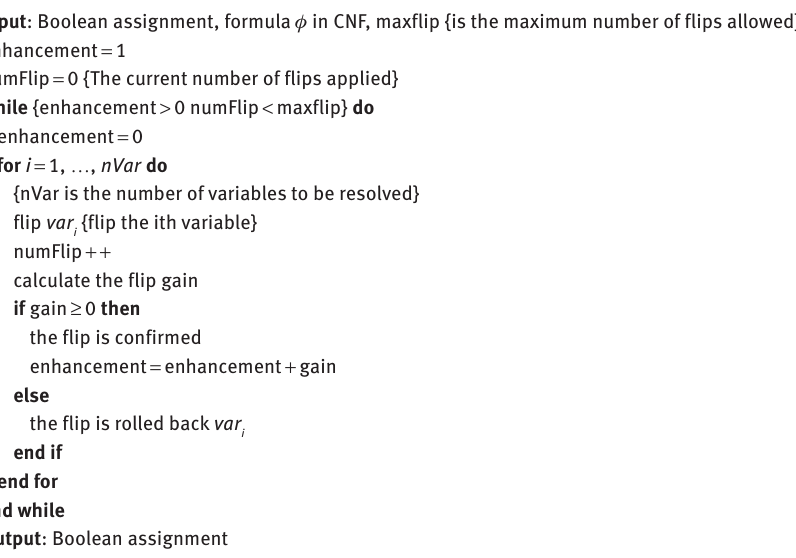
Algorithm 2: Local Search Procedure based on Flip Heuristic